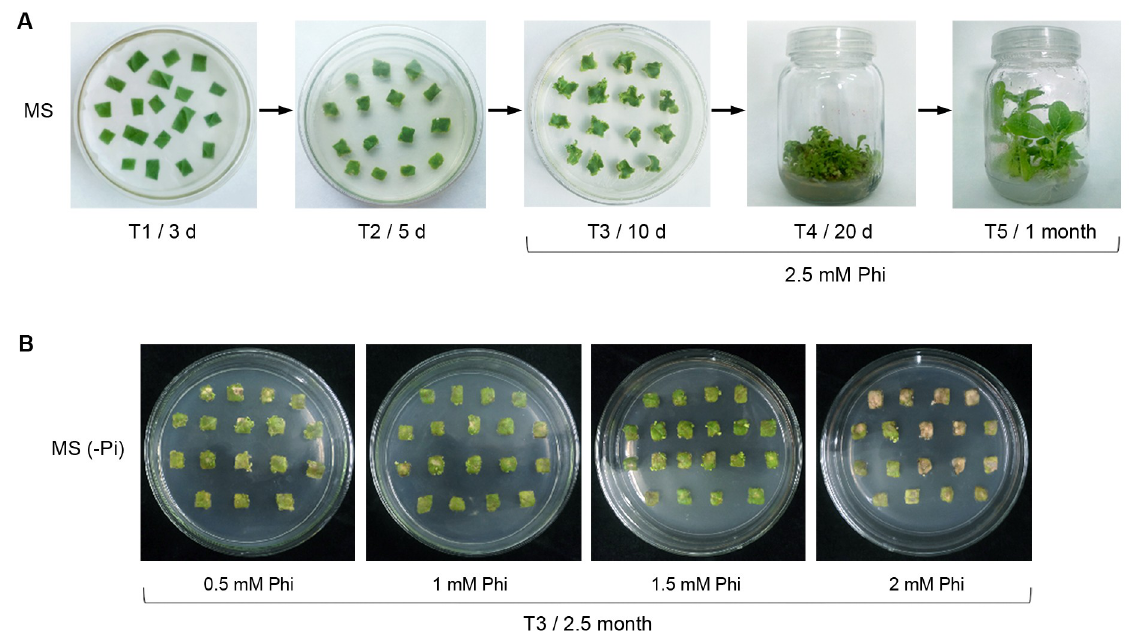
Fig 4. The Agrobacterium-infiltrated tobacco transformation of plant vector pET(EcBAP) under Phi selection. Experiments were performed on (A) standard MS medium and (B) MS (Pi-) medium without Pi supply.